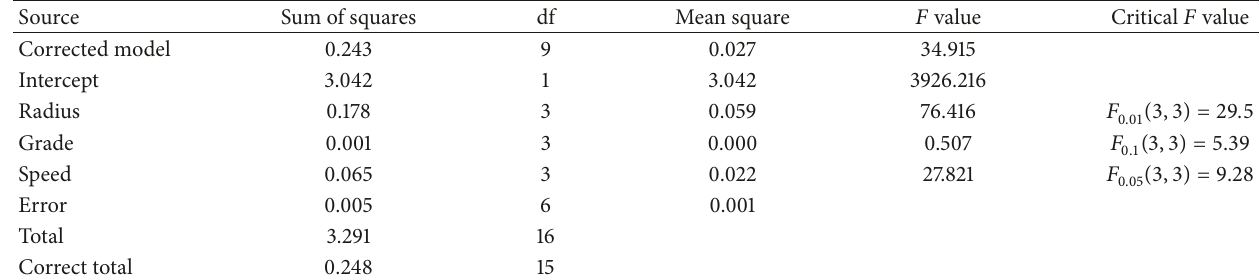
Table 5: Variance analysis of factors influencing the LTR on curved upgrades.